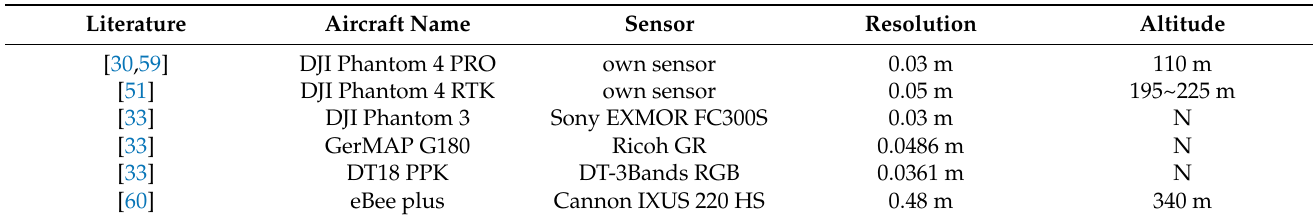
Table 2. Names, sensors, resolutions, and altitudes of remote sensing UAVs used in the